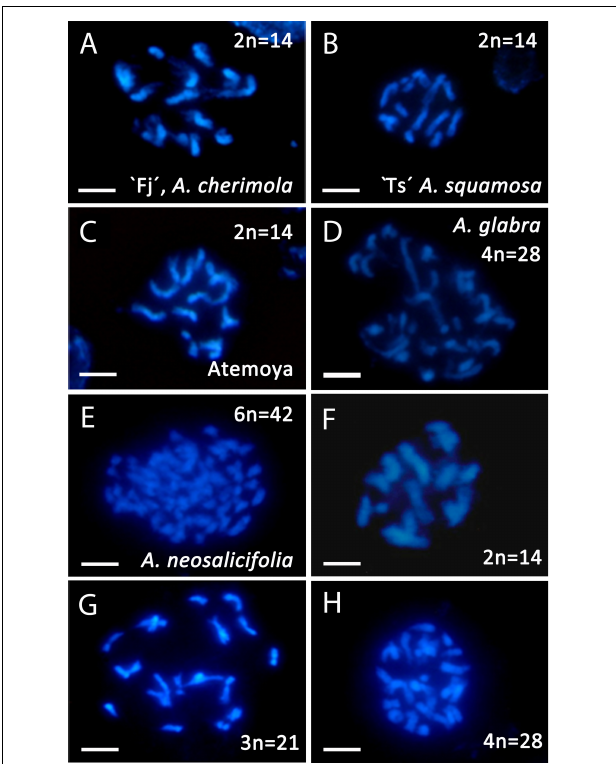
FIGURE 2 | Somatic chromosomes revealed using DAPI staining in Annona spp. (A) Diploid A. cherimola , cv. Fino de Jete, “Fj”, (B) Diploid A. squamosa , Thai seedless “Ts”, (C) Diploid atemoya. (D) Tetraploid A. glabra . (E) Hexaploid A. neosalicifolia . (F,H) Diploid hybrid (F) , triploid hybrid (G) and tetraploid hybrid (H) from the interspecific cross A. cherimola × A. squamosa . Scale bars, 10 µ